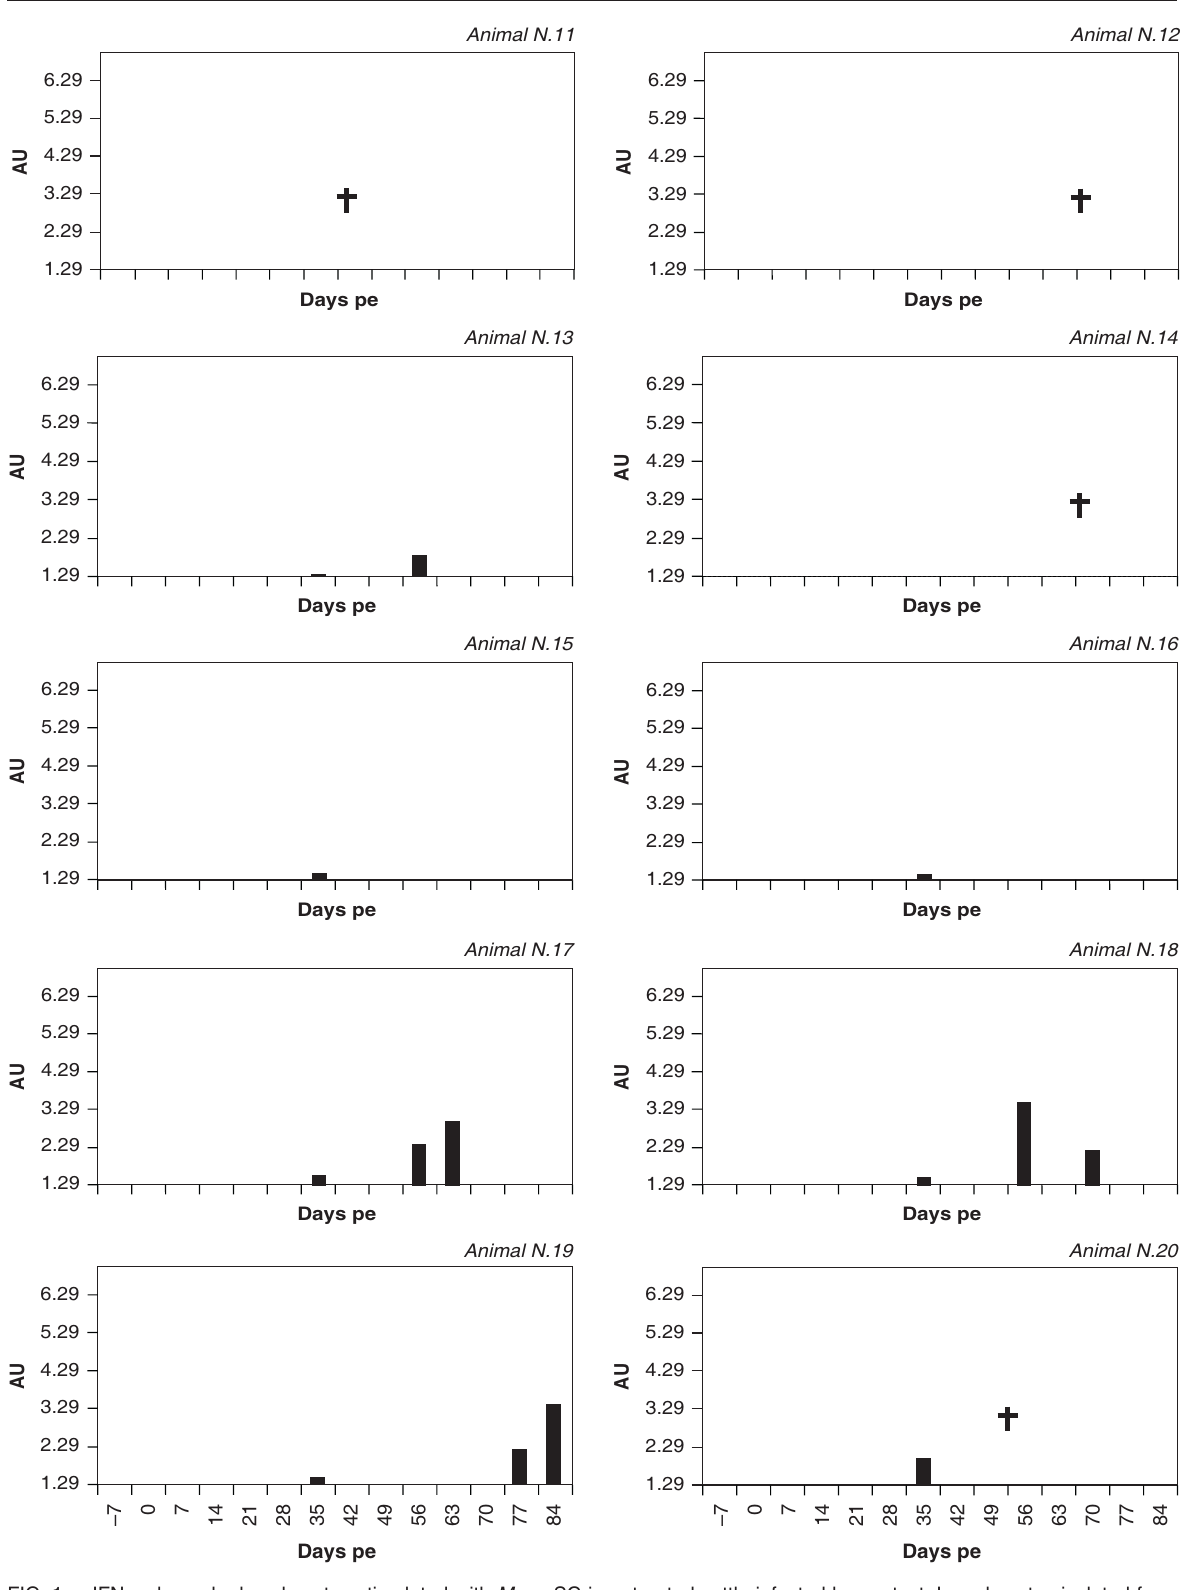
FIG. 1 IFN γ release by lymphocytes stimulated with Mmm SC in untreated cattle infected by contact. Lymphocytes isolated from blood were cultured with Mmm SC and incubated for 24 h. IFN γ from supernatant was measured using the ELISA